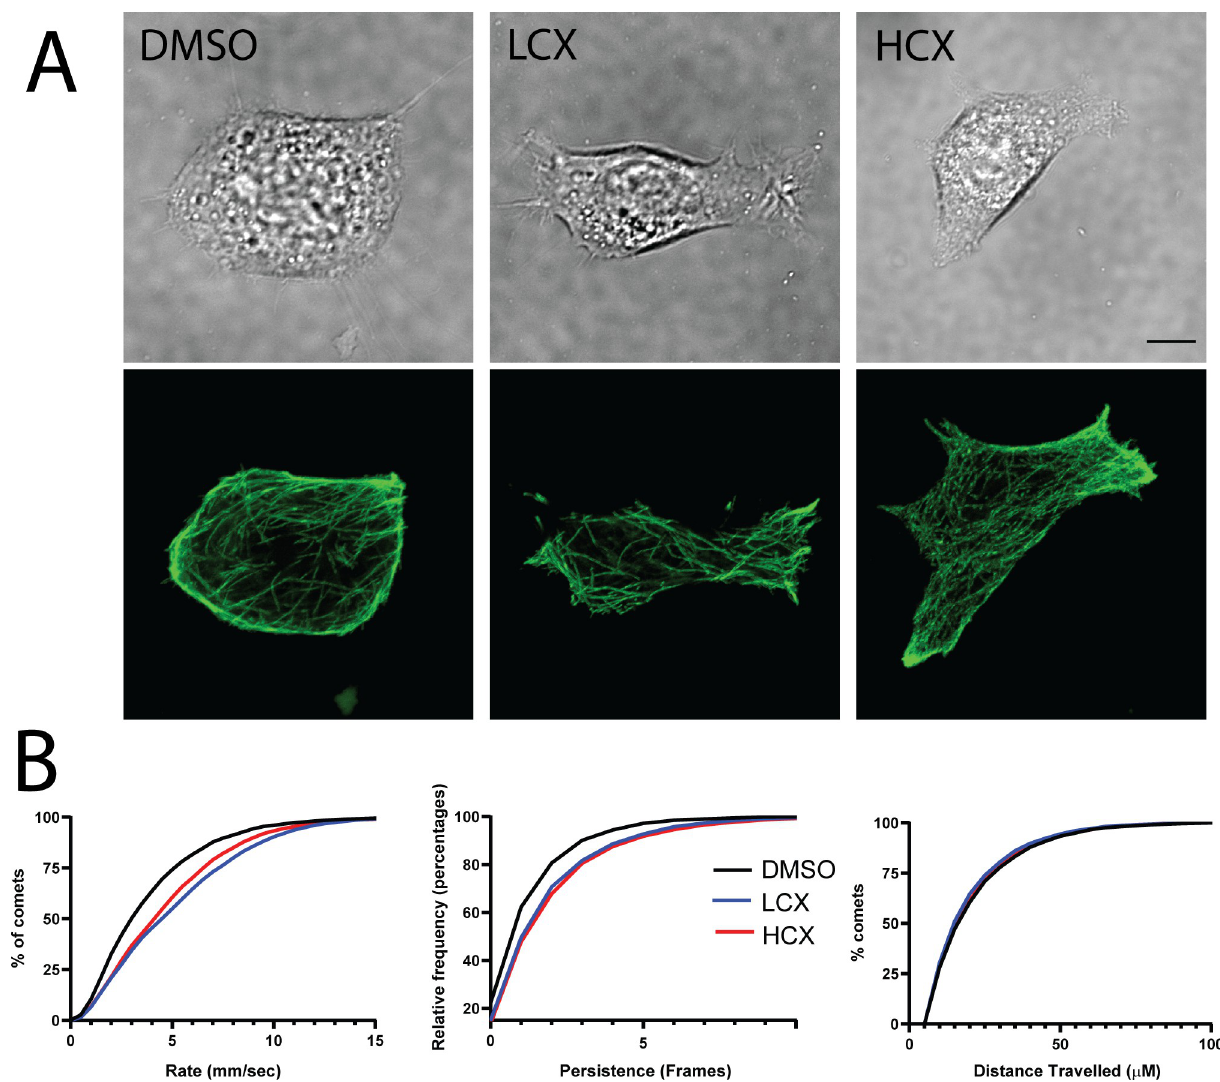
Fig 4. Xyloside treatment alters microtubule dynamics. A) Images of living Neuro2a cells (top) expressing EB3-EGFP were imaged over time. Bottom images show z-projections of 25 frames of fluorescent images of EB3-EGFP. B) Cumulative distribution plots of speed, persistence and total distance traveled by EB3 comets from DMSO, LCX and HCX-treated cells. Scale = 10 μ m.